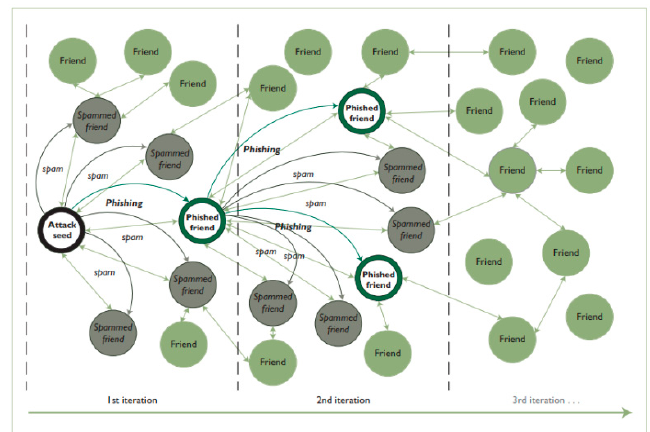
Figure 46. Outline of a large-scale spam campaign via the friend-in-the-middle attack. A social networking session is hijacked to fetch personal information from a victim’s profile. The extracted information is then used for spam and phishing emails targeted at the victim’s friends (Ref. [155]).